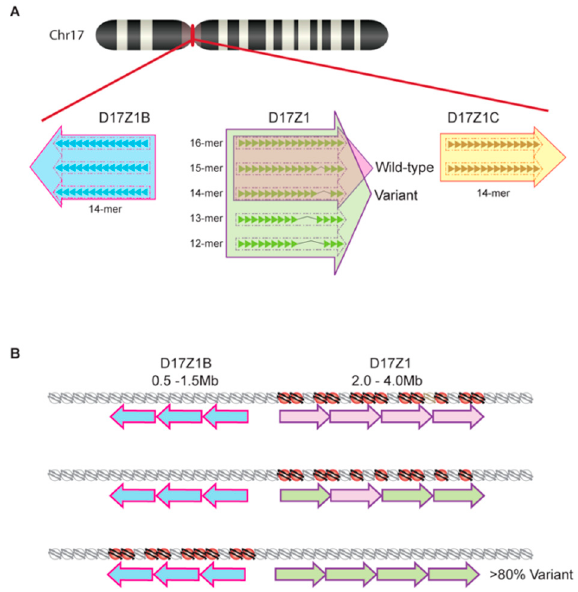
Figure 2. Chromosome 17 epialleles. ( a ) Ideogram of chromosome 17 (top). Zoom inset of epialleles showing monomer number for HORs and orientation. D17Z1B HORs carry 14 monomers, as do D17Z1C HORs. D17Z1 HORs are variable in the human population, with wild type epialleles containing 16-mer, 15-mer, and 14-mer HORs (pink) and variant epialleles containing wild type HORs in addition to 13-mer and 12-mer HORs (green). ( b ) Variation of the D17Z1 epiallele is linked to centromere activity. When the variation in D17Z1 increases, CENP-A nucleosomes (red) decrease; when variation exceeds 80%, the centromere assembles on the D17Z1B epiallele.